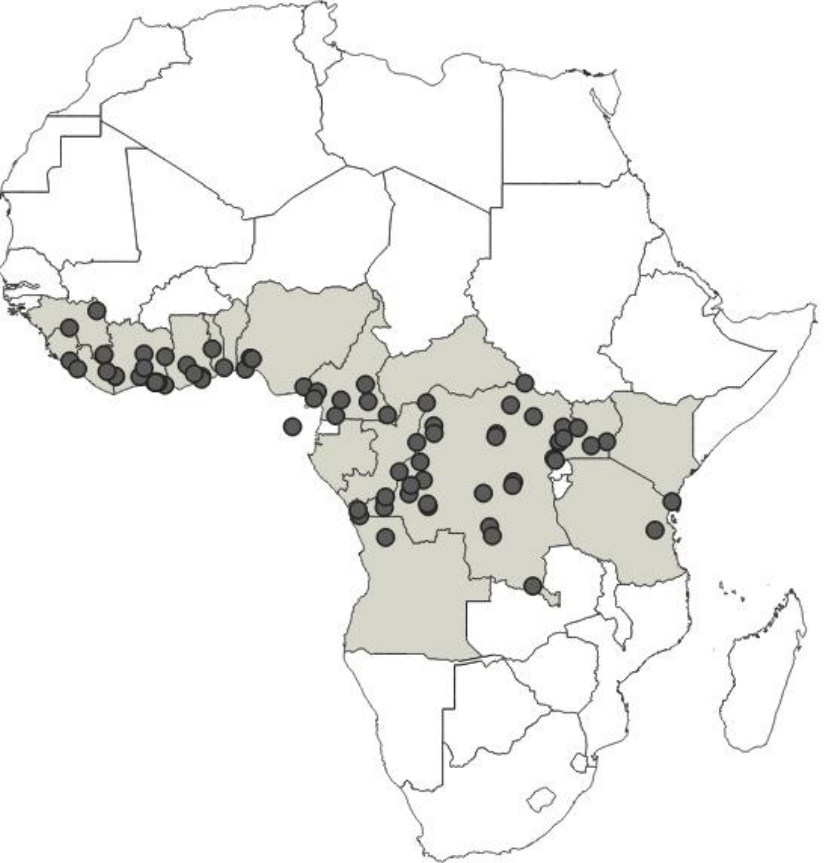
Figure 58. Known distribution of Phonoctonus principalis Gerstaecker, 1892.